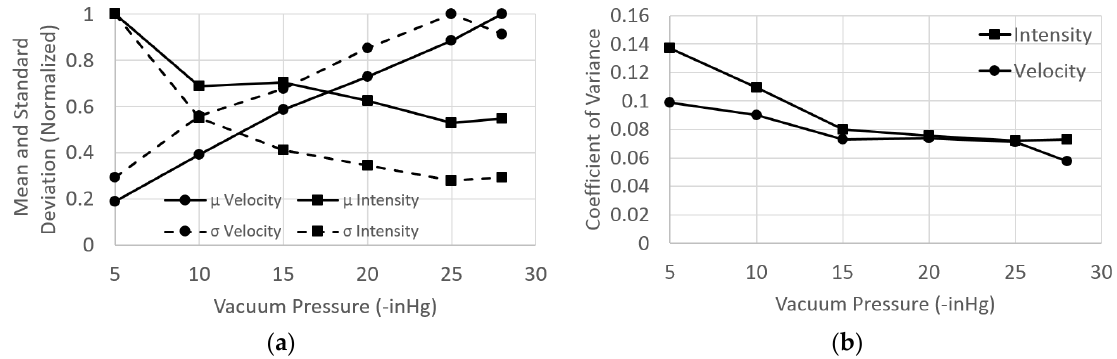
Figure 11. ( a ) With increasing vacuum pressure, the mean ( μ ) and standard deviation ( σ ) of the velocity increase while those of the intensity decrease ( b ) The coefficient of variance (CV) decreases with increasing vacuum pressure for both signal intensity and particle velocity before flattening out. Back pressure widens the focused sample stream at low operational pressures but is dominated at higher pressures.